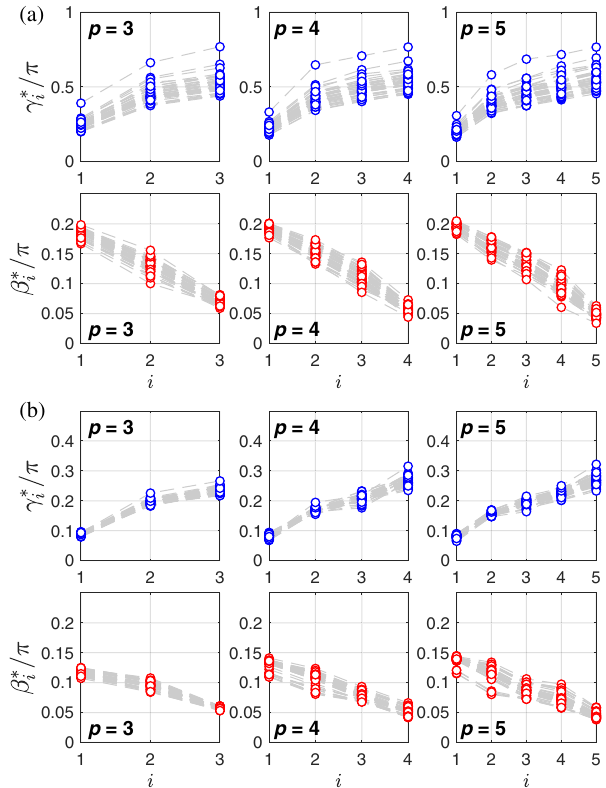
⃗ β (cid:3) FIG. 9. Optimal QAOA parameters ð ⃗ γ (cid:3) ; Þ for 40 instances of 16-vertex (a) w3R graphs and (b) weighted complete graphs, for 3 ≤ p ≤ 5 . Each dashed line connects parameters for one particular graph instance. For each instance and each p , the BFGS routine is used to optimize from 10 4 random initial points, and the ⃗ β (cid:3) best parameters are kept as ð ⃗ γ (cid:3) ; Þ